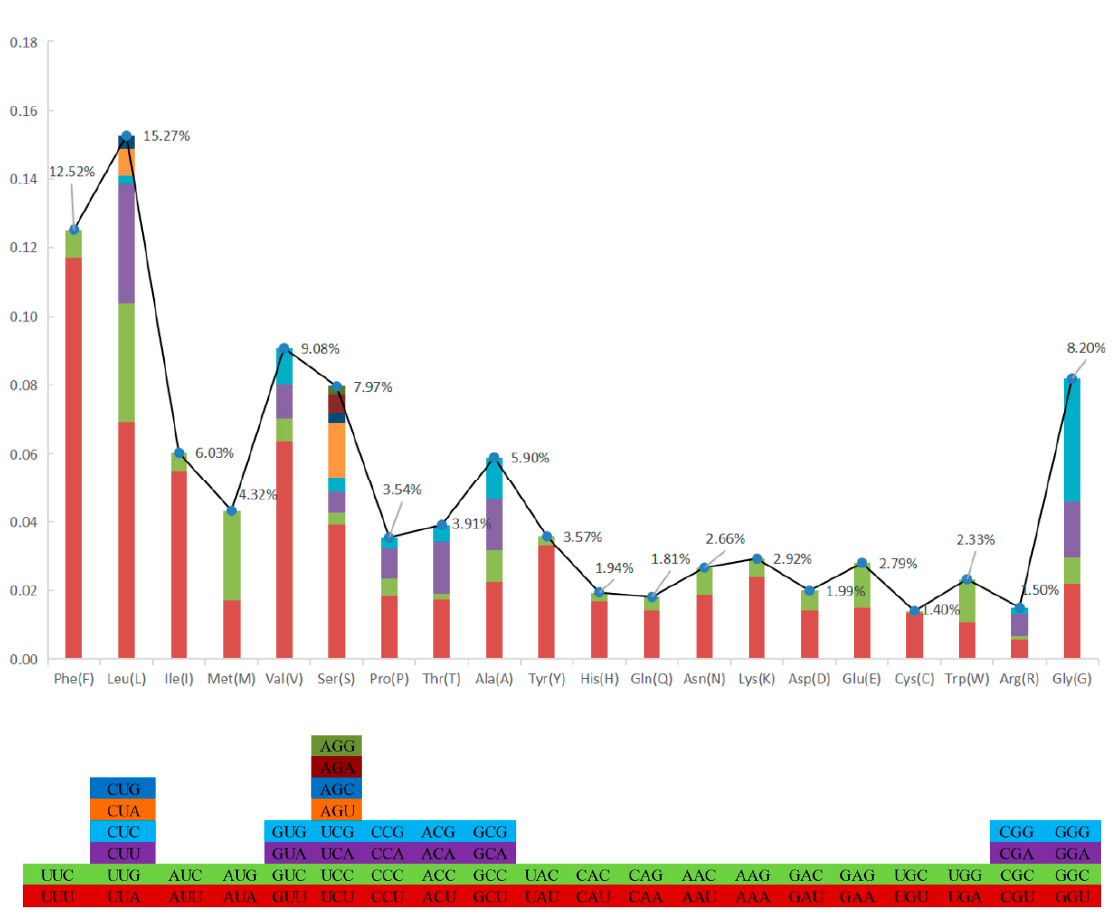
Figure 5. Codon use frequency of PCGs in mitogenome of H. bowerbanki .